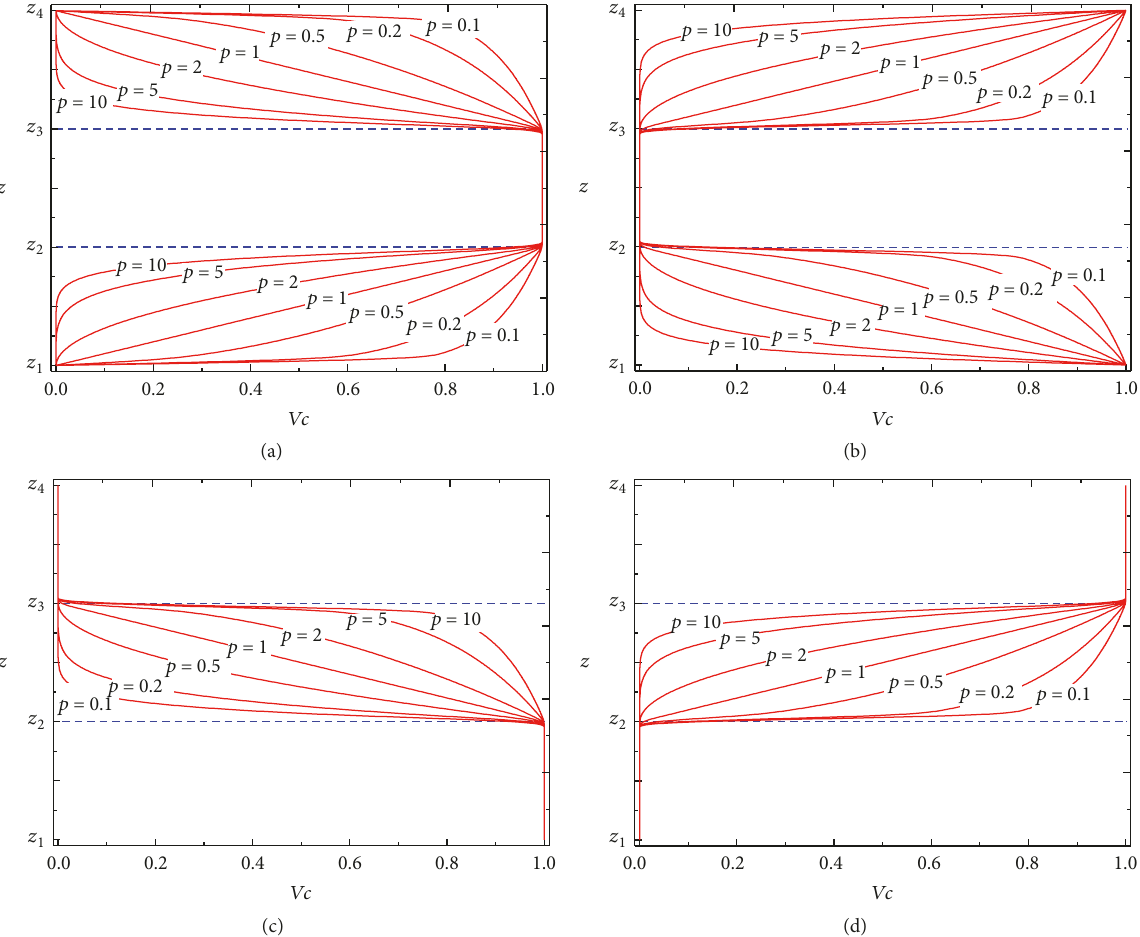
Figure 3: Variation of volume fraction Vc along the thickness for different value of power-law exponent: (a) Type 1-1; (b) Type 1-2; (c) Type 2-1; (d) Type 2-2.